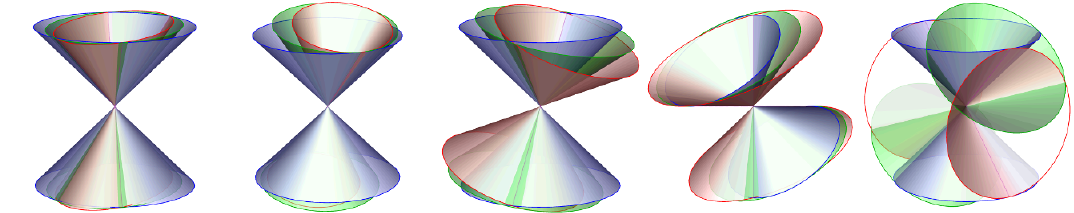
Figure 5 . The null cones of h , in green, relative to f and g